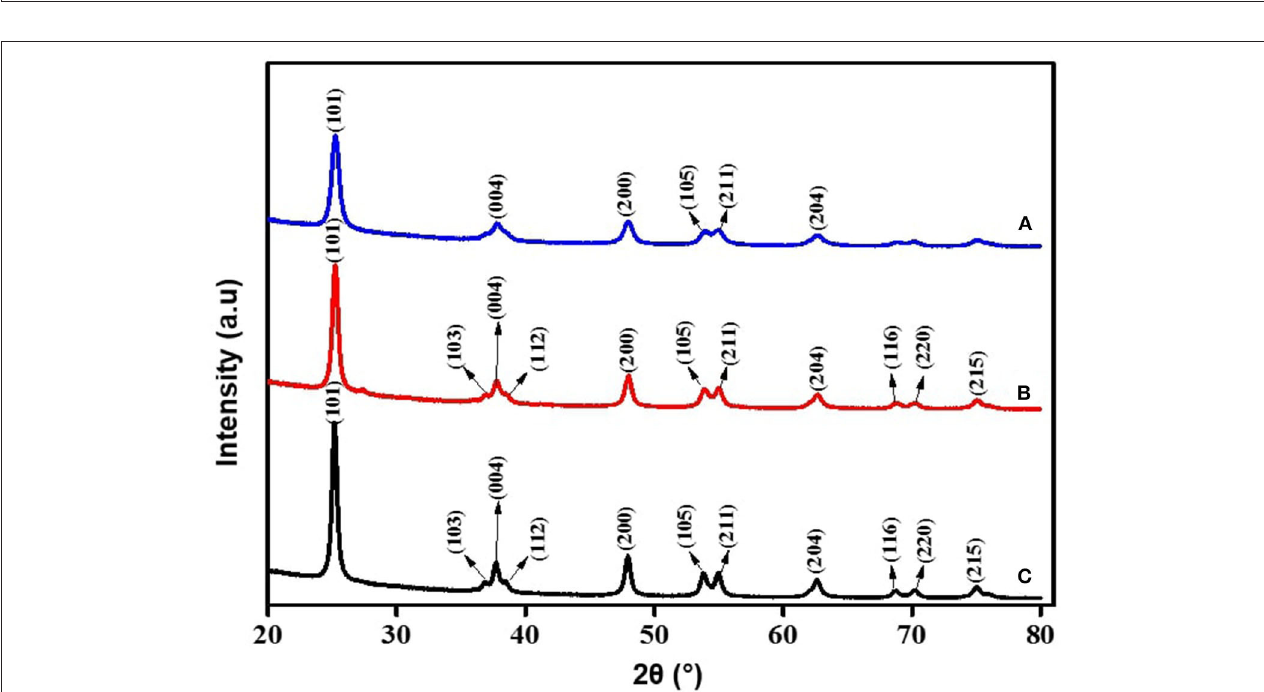
FIGURE 4 | XRD patterns of green TiO 2 NPs synthesized from the extracts of D. pinnata plant using (A) methanol, (B) n -hexane, and (C) ethyl acetate as the extraction solvents.